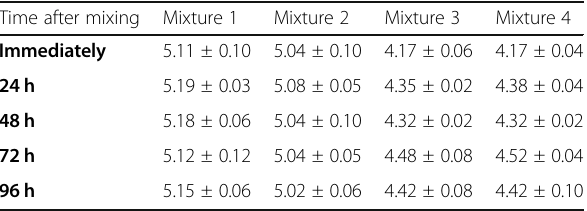
Mixture 1: fentanyl, oxycodone, nefopam, and ondansetron; mixture 2: fentanyl, oxycodone, nefopam, and ramosetron; mixture 3: fentanyl, hydromorphone, nefopam, and ondansetron; mixture 4: fentanyl, hydromorphone, nefopam, and ramosetron. Data are presented as the mean ± standard